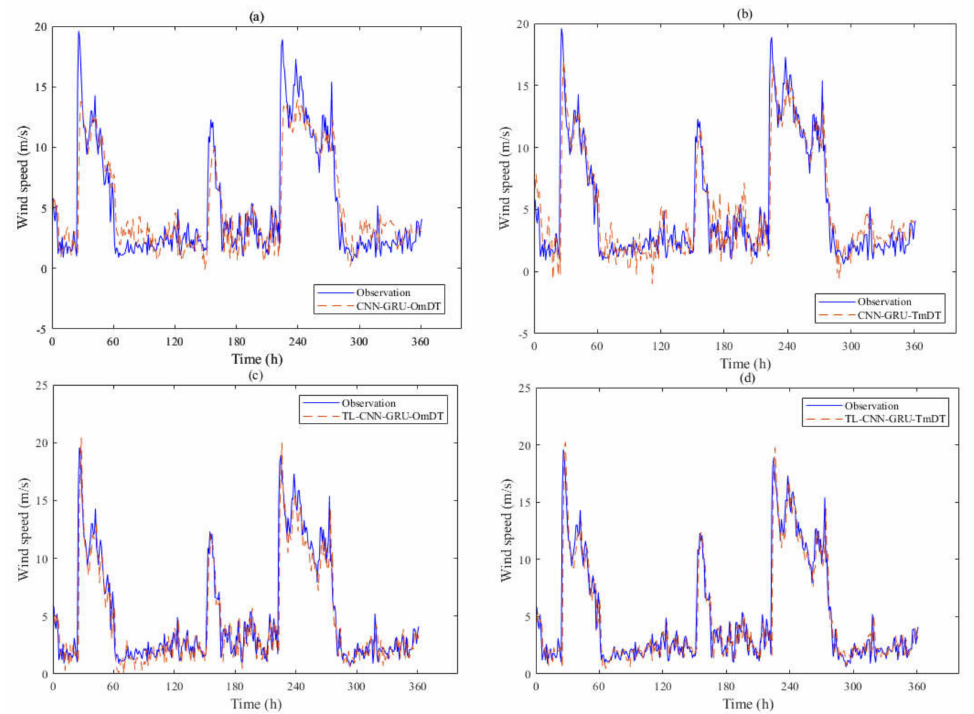
Figure 8. Comparison of different model predicted value and the real value: ( a )